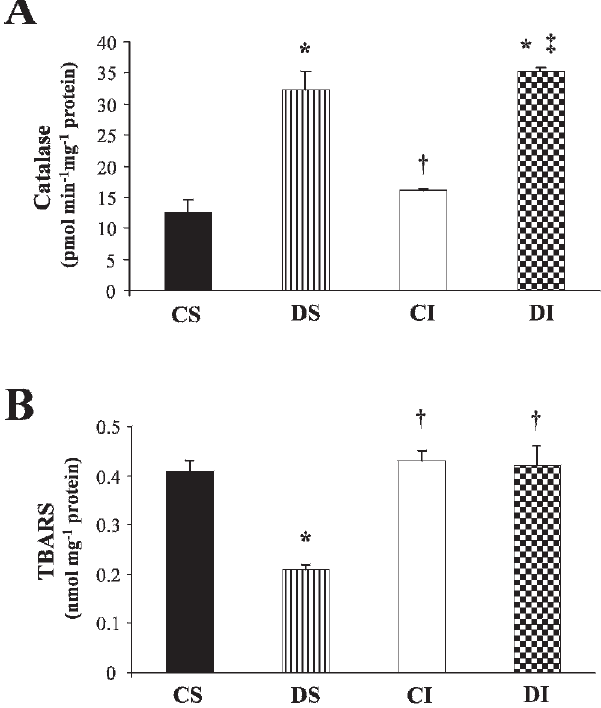
Figure 1 - Oxidative profiles of cardiac homogenates in control sham (CS), diabetes sham (DS), myocardial infarction (CI), and diabetes + myocardial infarction (DI) rats (n=8 for each group). A: Catalase activity. B: Lipid peroxidation indicated by thiobar- bituric acid-reactive substances (TBARS). * p , 0.05 vs . CS; { p , 0.05 vs. DS; { p , 0.05 vs . CI.